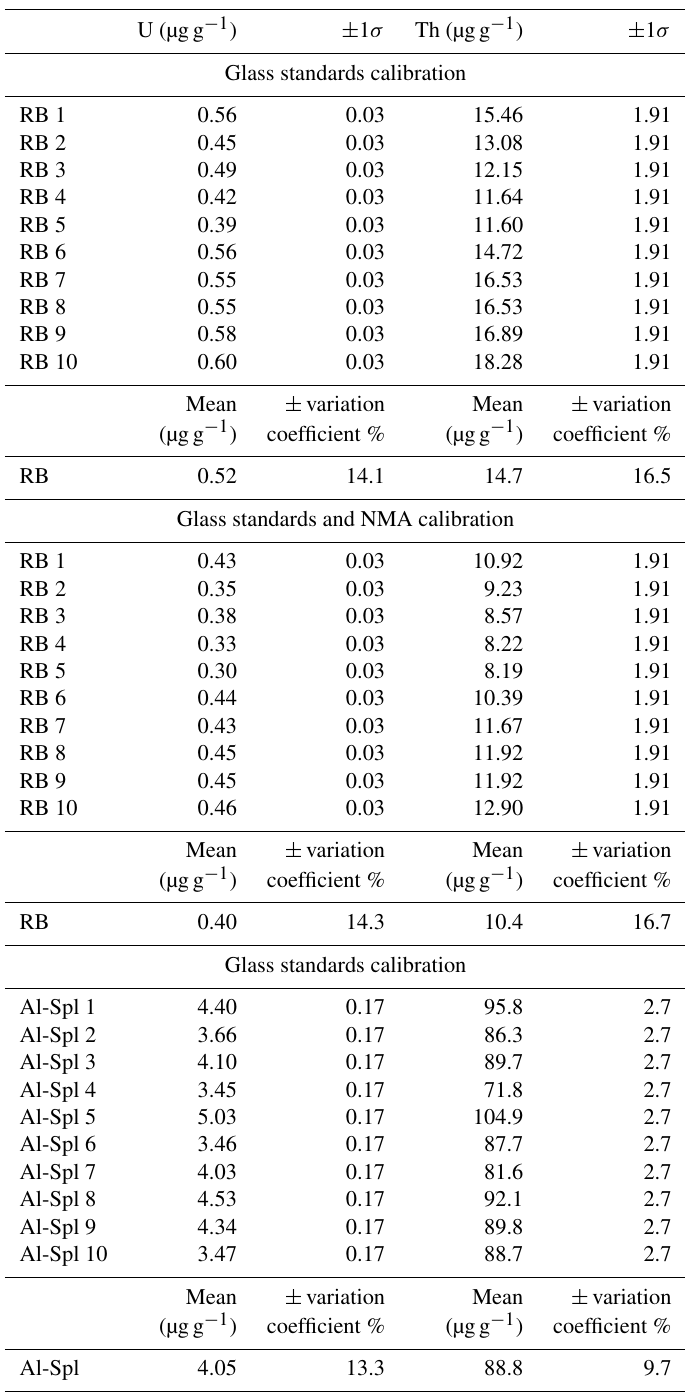
Table 5. U and Th concentration determined using LA-ICP-MS method with two types of calibration (silicate glasses only and silicate glasses plus NMA